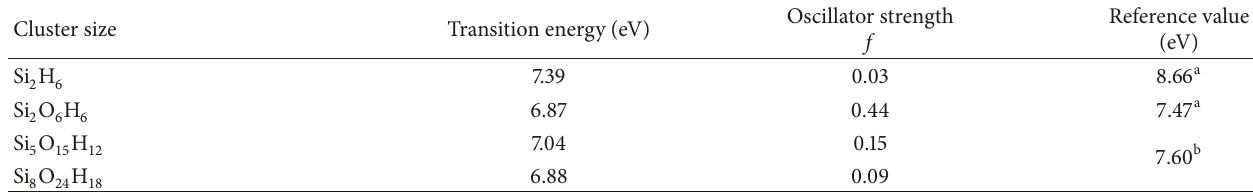
Figure 4: (a)–(d) ELF of the Si-Si band in 𝛼 -quartz cluster configurations with ODC(I); (e)–(h) orbital wave function of HOMO in 𝛼 -quartz cluster configurations with ODC(I). Green and blue color represent positive and negative phase of the orbital wave function, respectively. Table 2: Summary of computed s 0 → s 1 transition energy of the cluster configurations with ODC(I) defects, neglecting other paramagnetic